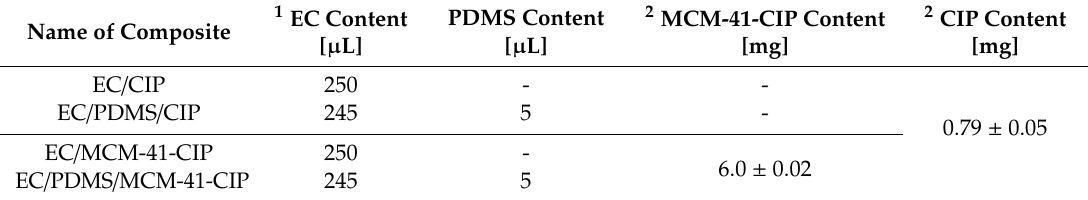
Table 1. The qualitative and quantitative composition data of